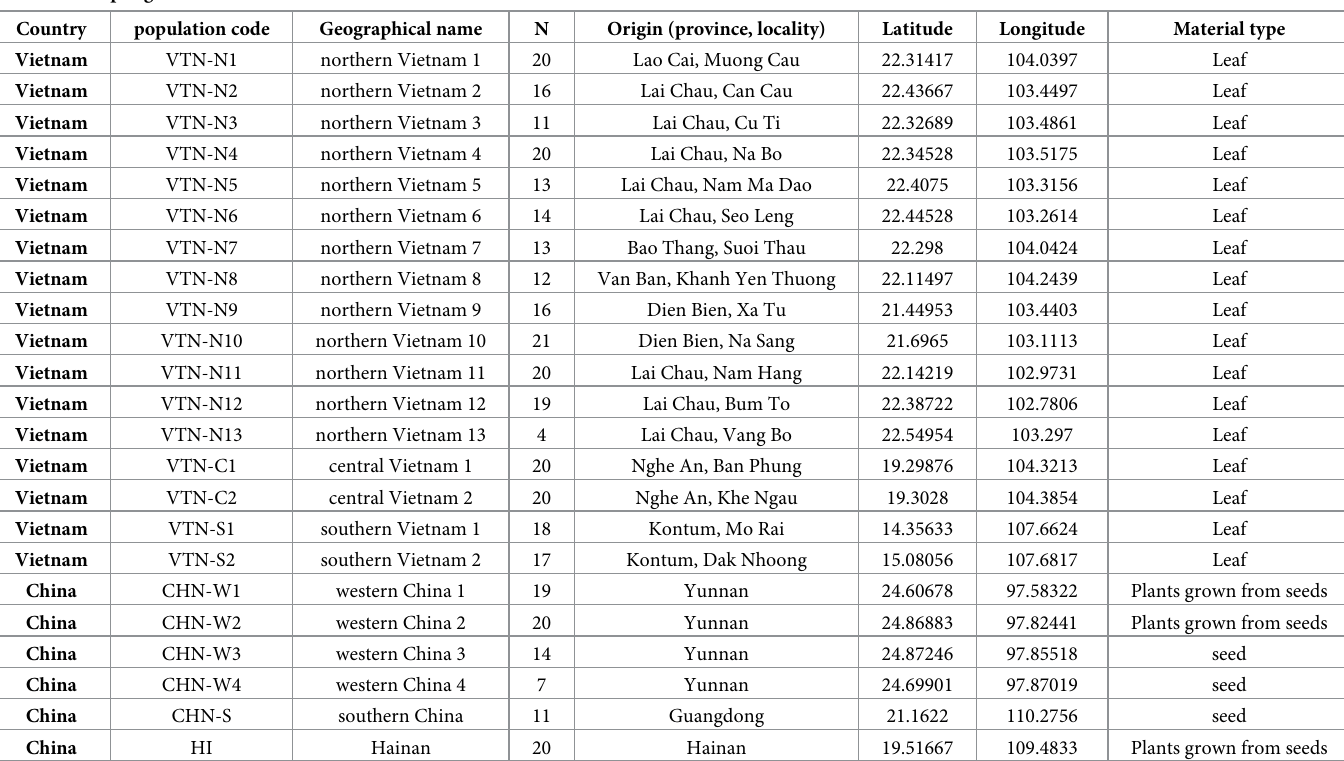
Table 1. Sampling location